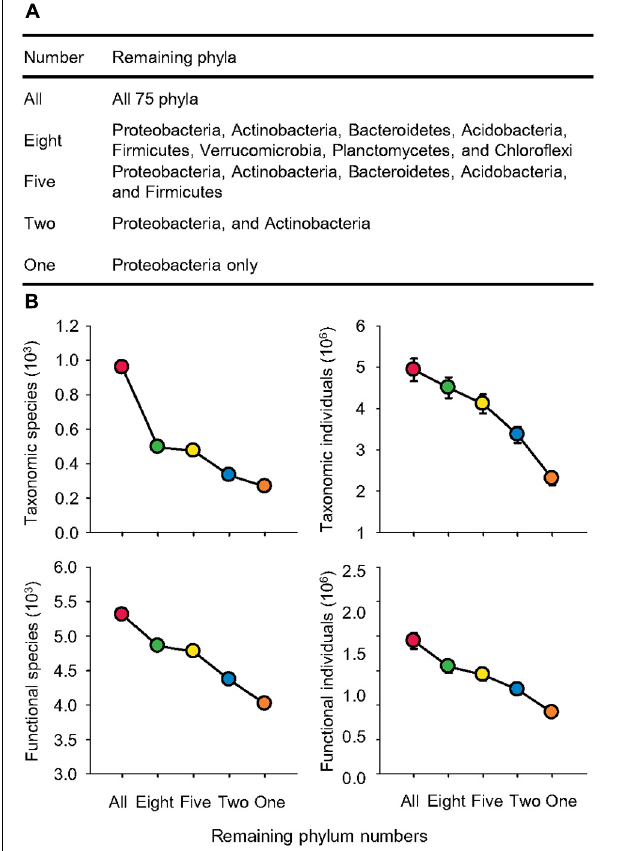
FIGURE 2 | Significant species loss. (A) Names of remaining phyla following sequential species loss. (B) The species (S) and individuals (N) of taxonomic compositions at the genus levels and functional categories at the function levels affected by sequential species